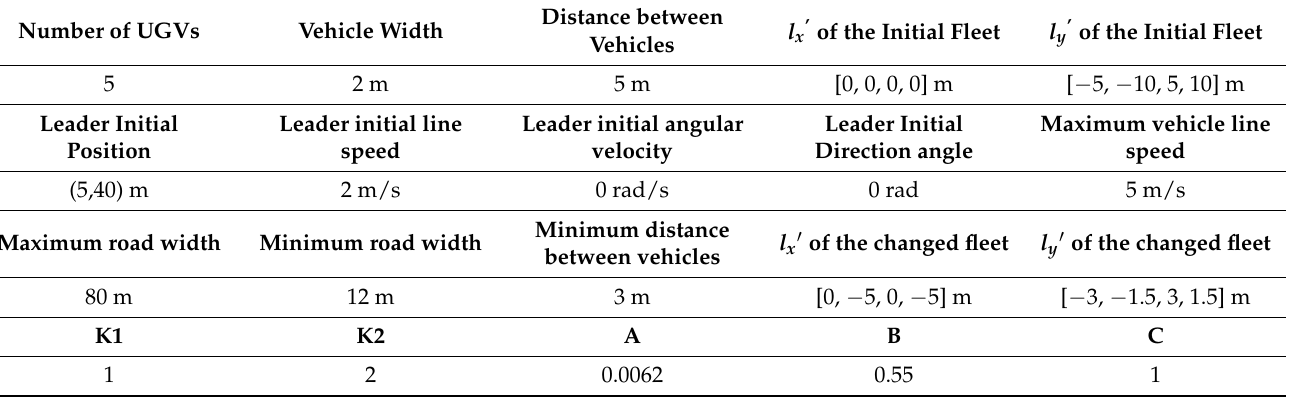
Table 2. The relevant parameters in case of road narrowing.